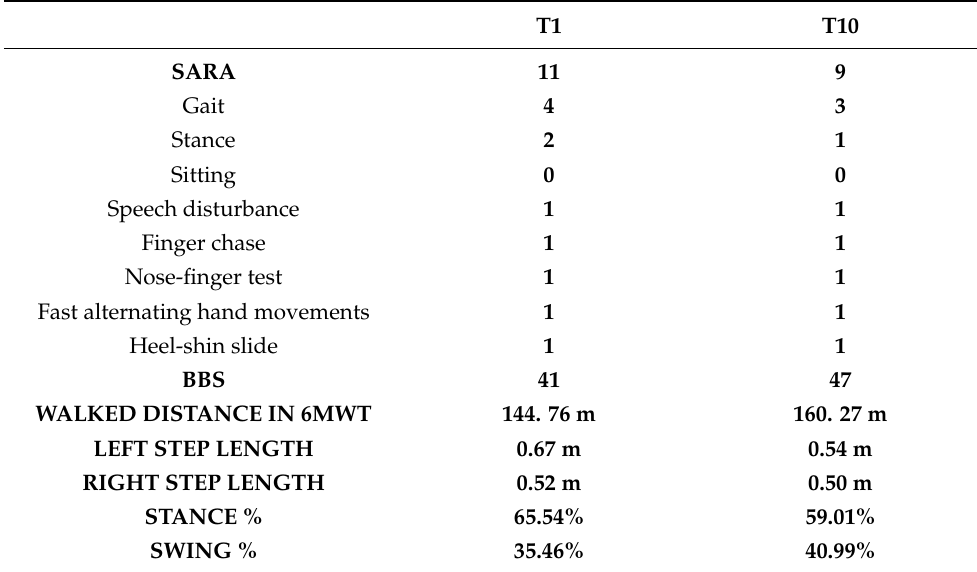
Table 2. Comparison of T1-T10 outcome scores; as shown, the patient had lower impairment at SARA scale, a better balance control at BBS, improved distance at 6MWT, and a better distribution regarding gait